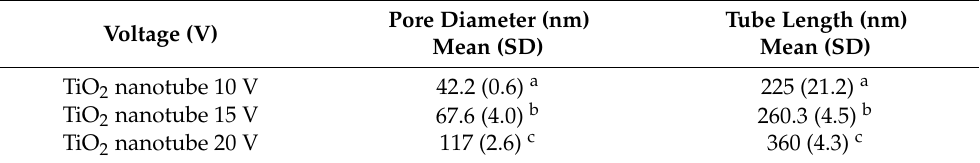
Table 2. The morphology parameters (pore diameter and tube length) of TiO 2 nanotube arrays at different voltages ( n = 3). Different superscript letters within the value indicate statistically different